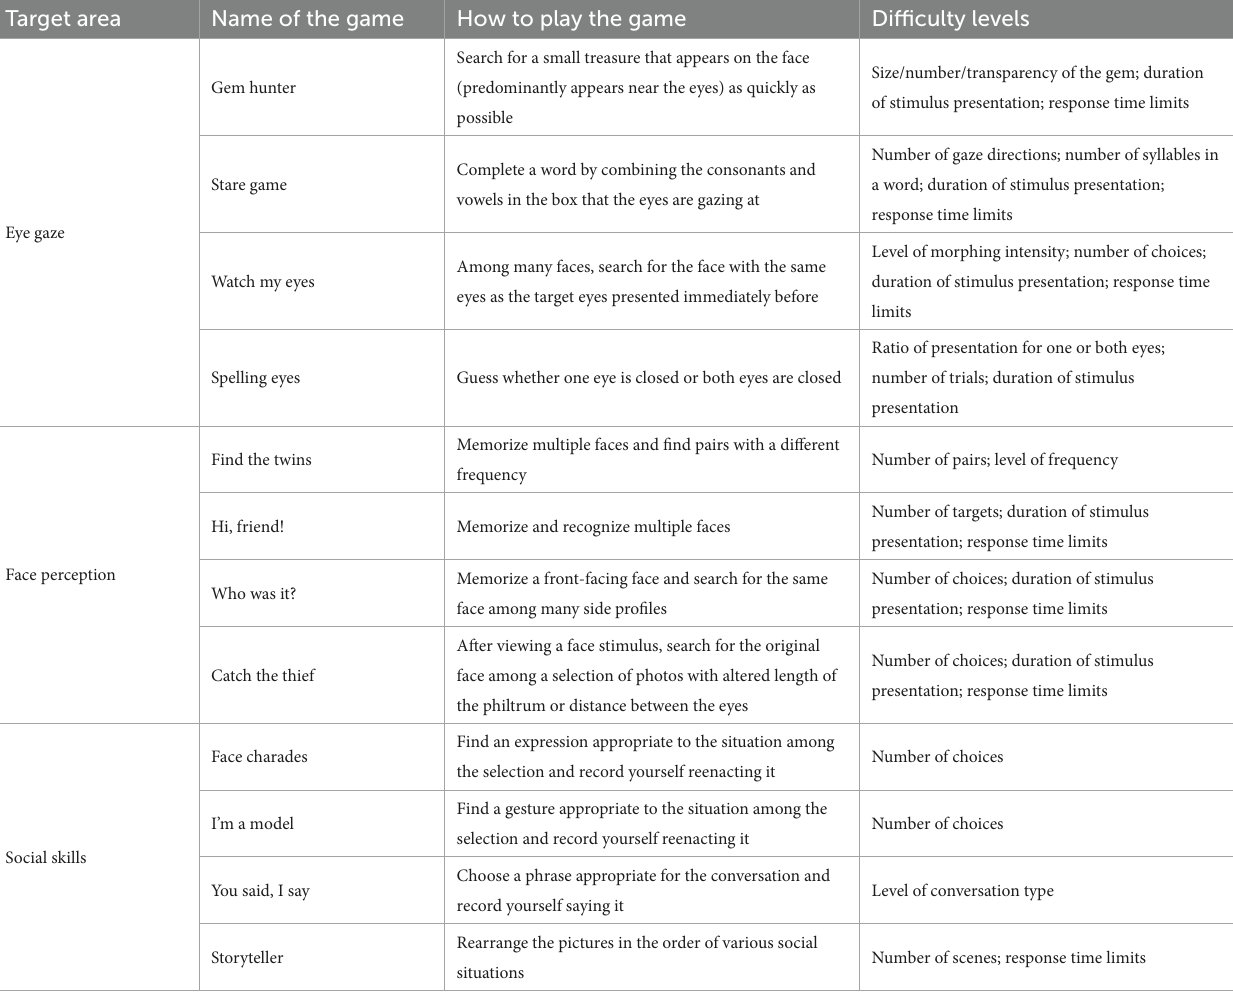
TABLE 2 Description of the 12 games in the Yface training program. Target